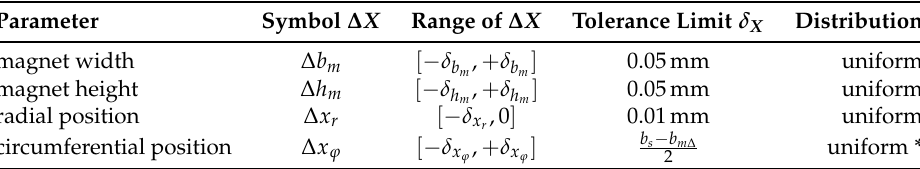
Table 2. Tolerance